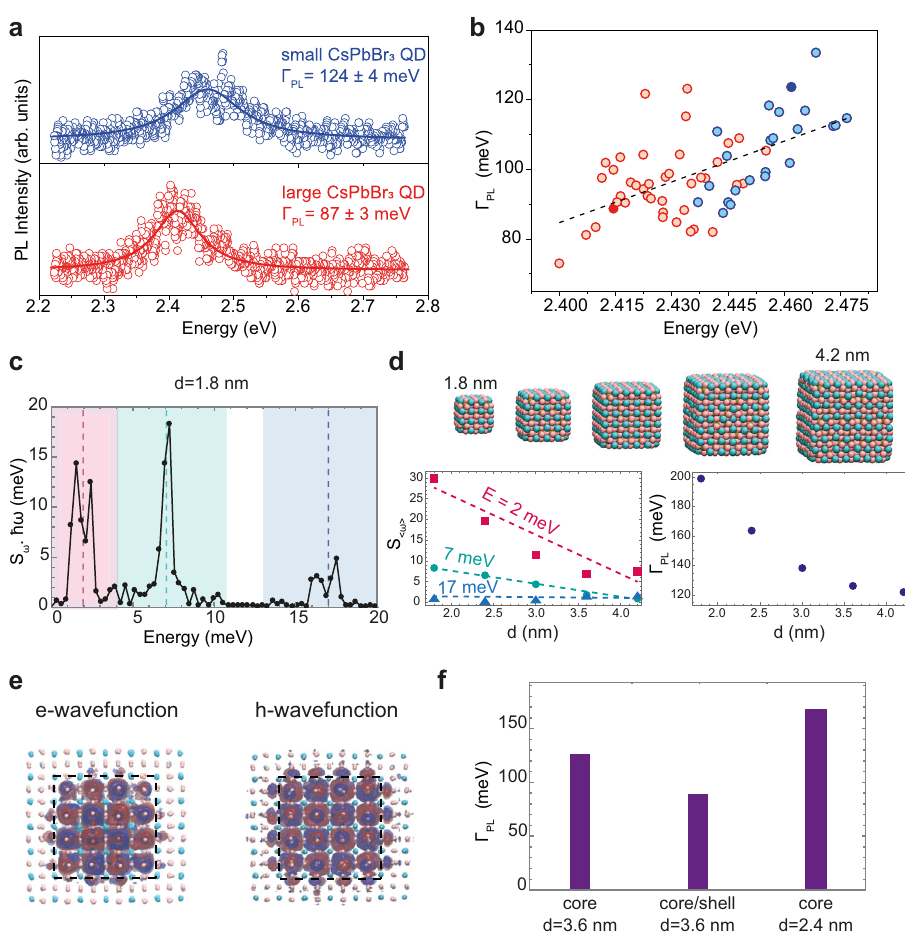
Fig. 2 Size-dependent emission line-broadening in perovskite QDs and its origin. a Two representative PL spectra of single QDs with different sizes. Solid lines are best fi ts of a Lorentzian function to the experimental data (colored open circles). b Statistics of emission line-broadening for various QDs: red and blue circles denote the emission broadening of QDs from two different batches. The circles fi lled in dark red and dark blue denote the emission linewidth values of the PL spectra in a . c The reorganization energy S ω (cid:1) _ ω as a function of the phonon energy _ ω ( S ω is the Huang – Rhys parameter for the lowest energy band-to-band transition). The different phonon modes are highlighted by shaded rectangles and dashed lines. The low-to-intermediate energy modes (2 and 7 meV) dominate the broadening. d Computationally explored QD size range from 1.8 to 4.2 nm (top plot). Computed size-dependent Huang – Rhys factor S (left plot) for the three phonon modes, where < ω > indicates an effective coupling assuming a single mode in each of the three < ω > regions shown in c indicated by the dashed lines (see Supplementary Eq. (6)): while the high-energy mode (17 meV, blue triangles) has no dependence vs. QD size, strong variation is observed for the low-to-intermediate energy modes (red squares and green circles, respectively). Colored dashed lines are guide for the eye. The calculated emission broadening Γ PL (blue circles) vs. QD diameter is reported in the plot on the right. e Calculated electron and hole wavefunctions in a CsPbBr 3 /CsCaBr 3 heterostructure, showing a clear type-I alignment. f Comparison of calculated line-broadening for core-only and core/ shell QDs: for QDs with an edge length of 3.6 nm, the emission in a core/shell QD (90 meV) is narrower than in a core-only QD (126 meV). The shell- induced PL narrowing is even more signi fi cant when compared to a core-only QD emitting at the same energy, i.e. a QD with an edge length of 2.4 nm exhibiting a PL broadening of 164